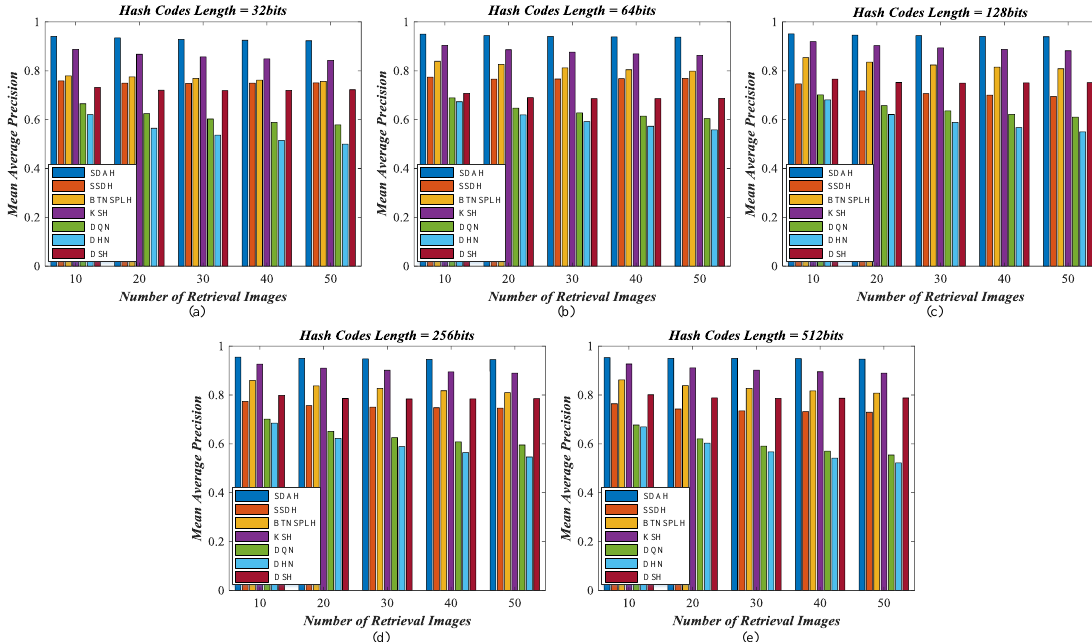
Figure 11. Mean average precision counted on different number of retrieval images using diverse hashing methods for AID archive: ( a ) the length of hash codes is 32 bits; ( b ) the length of hash codes is 64 bits; ( c ) the length of hash codes is 128 bits; ( d ) the length of hash codes is 256 bits; and ( e ) the length of hash codes is 512